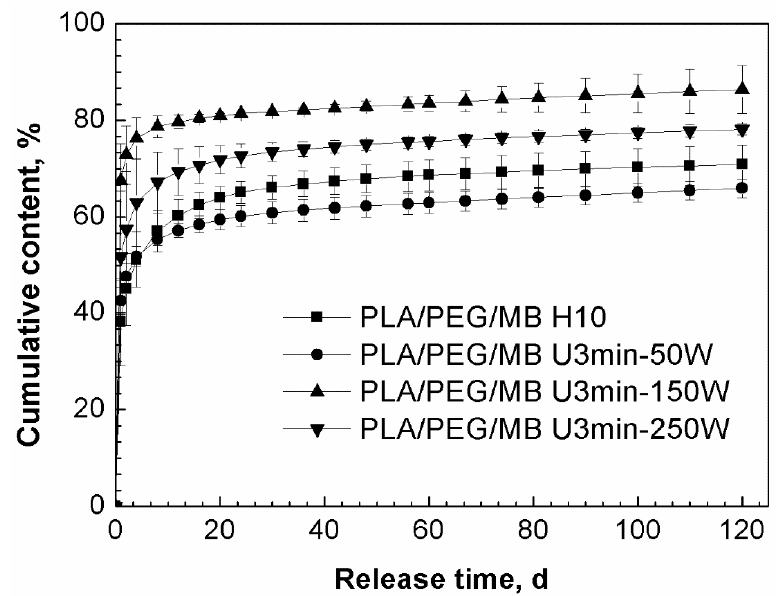
Figure 5. Effect of ultrasound on the release behavior of MB from PLA/PEG (65/35) blends PBS for 120 days (PLA / PEG / MB H10: without ultrasound treatment, PLA / PEG / MB U3min-50W: treated immersed in PBS for 120 days (PLA/PEG/MB H10: without ultrasound treatment, PLA/PEG/MB U3 by 50 W ultrasound for 3 min, PLA / PEG / MB U3 min-150 W: treated by 150 W ultrasound for 3 min, min-50 W: treated by 50 W ultrasound for 3 minutes, PLA/PEG/MB U3 min-150 W: treated by 150 W PLA / PEG / MB U3min-250W: treated by 250 W ultrasound for 3 min). ultrasound for 3 minutes, PLA/PEG/MB U3 min-250 W: treated by 250 W ultrasound for 3 minutes).